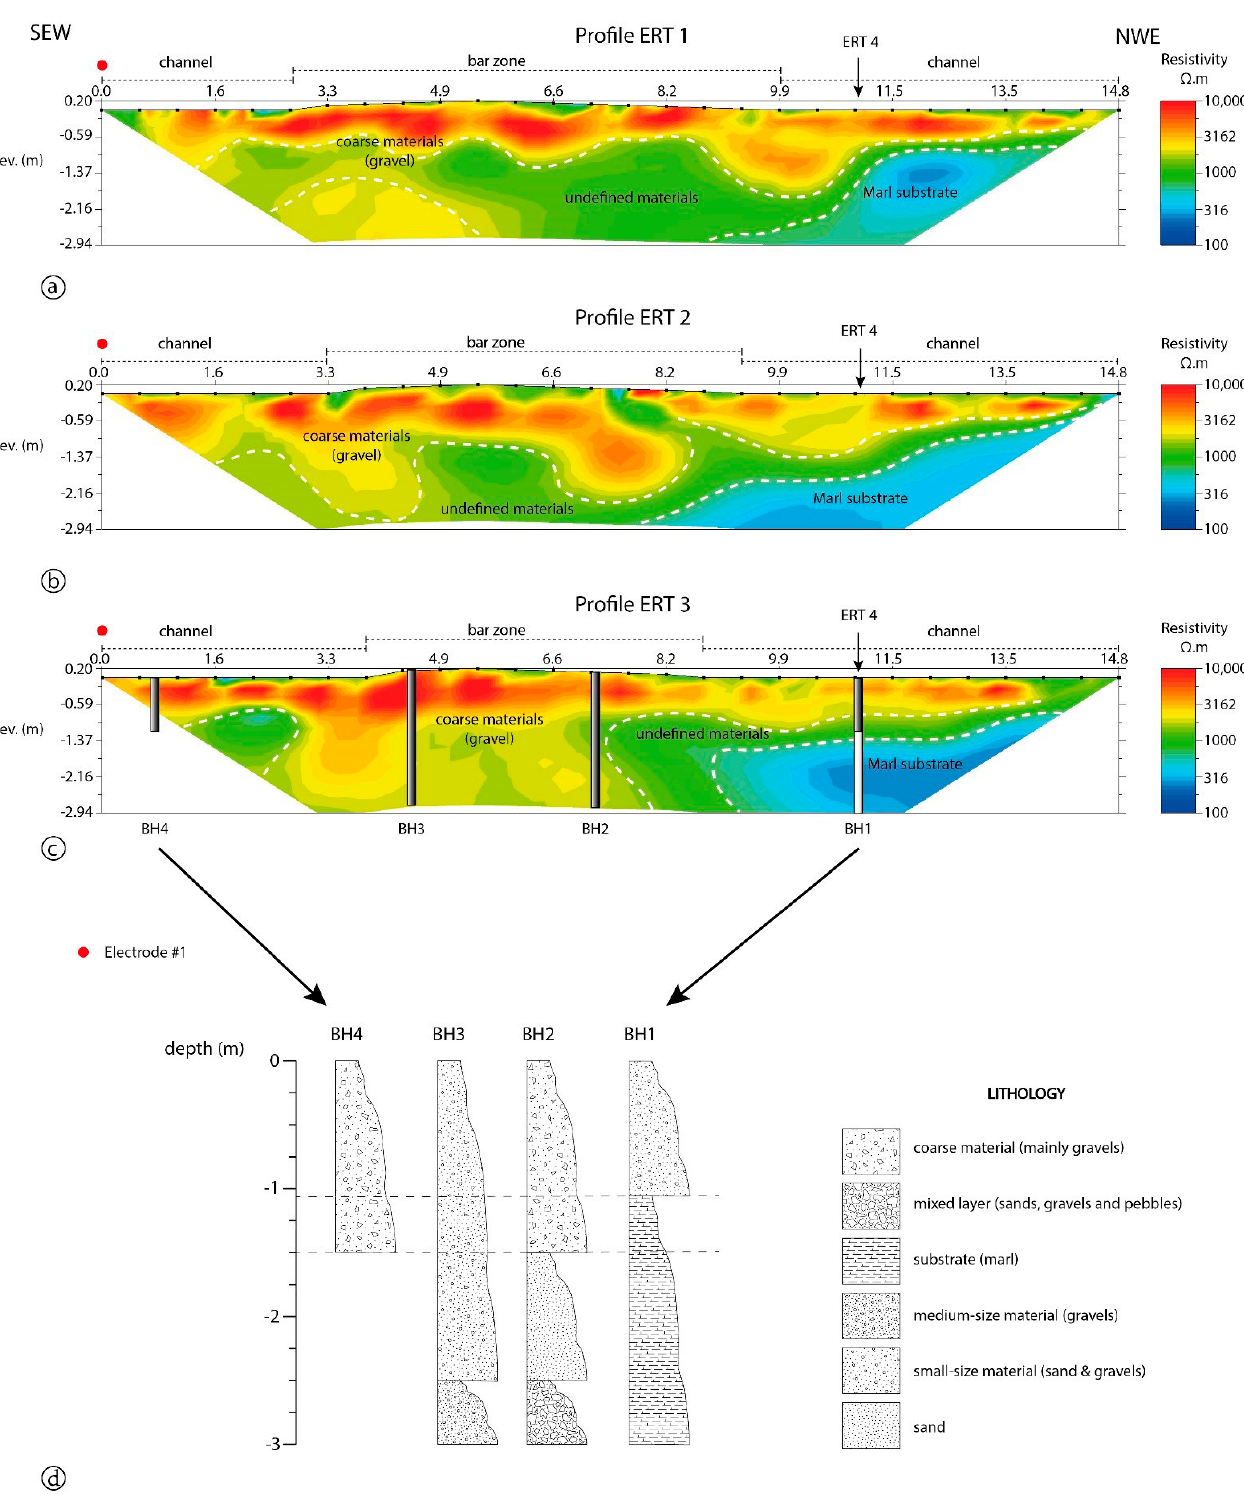
Figure 4. ( a – c ) Parallel ERT profiles (ERT1-ERT3). ERT4 intersects all profiles. BH1-BH4 are the boreholes drilled in the study area. ( d ). Lithology from BH1-BH4. Besides, the profiles ERT1–ERT3 identified the marl substrate featured with lower resistivity values (blue-cyan in the colour bar), which confirms the results obtained from the ERT4 profile. The 2D ERT study reproduced the physical structure of the channel, it presented a central bar and two lateral channels. ERT1 was in the upstream